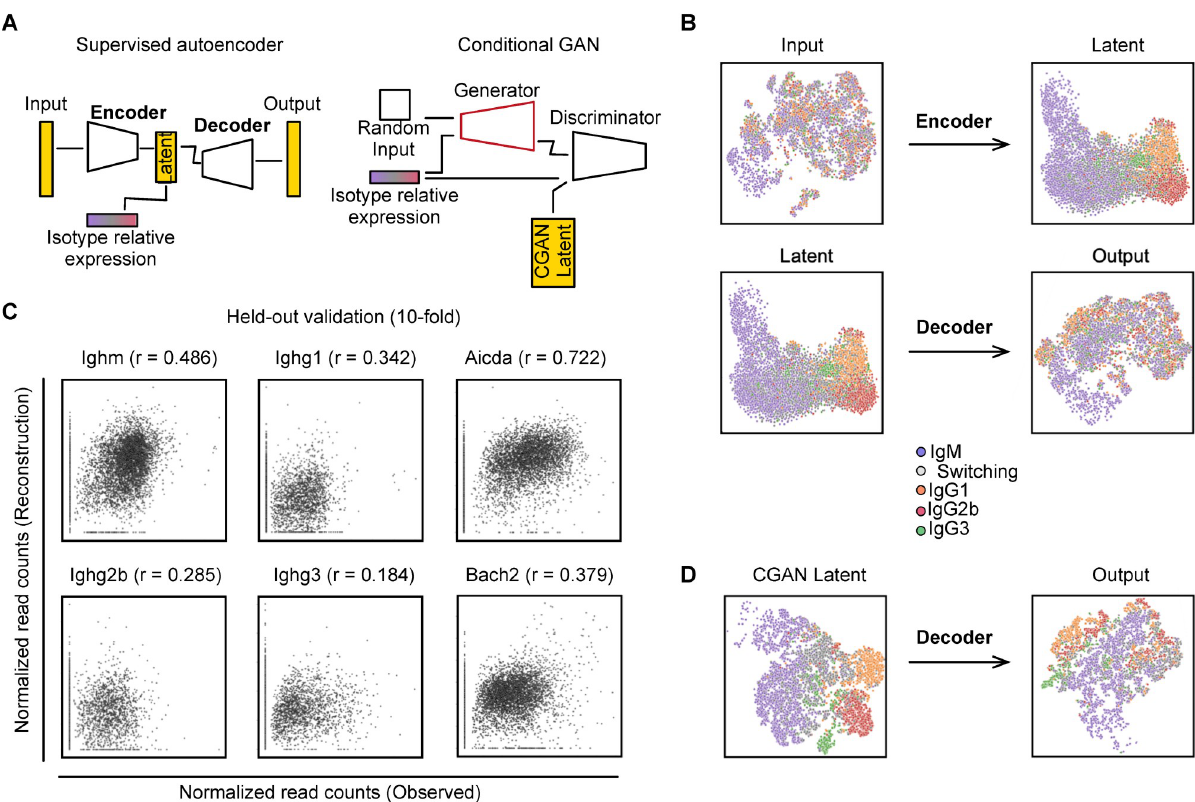
Fig 3. Pseudocell Tracer efficiently integrates adjacent biological information and accurately simulates gene expression profiles in pseudocells. (A) Overview of neural network model combining a supervised autoencoder with a conditional GAN. (B) UMAP visualization of the input and output used in the supervised autoencoder; encoder (top) and decoder (bottom). (C) Scatter plot between observed and predicted expression values on held out cells. r denotes Pearson correlation between ground truth and predicted values. Isotype expression (left) and example CSR genes (right). (D) UMAP visualization applied to cGAN prediction and subsequent output from